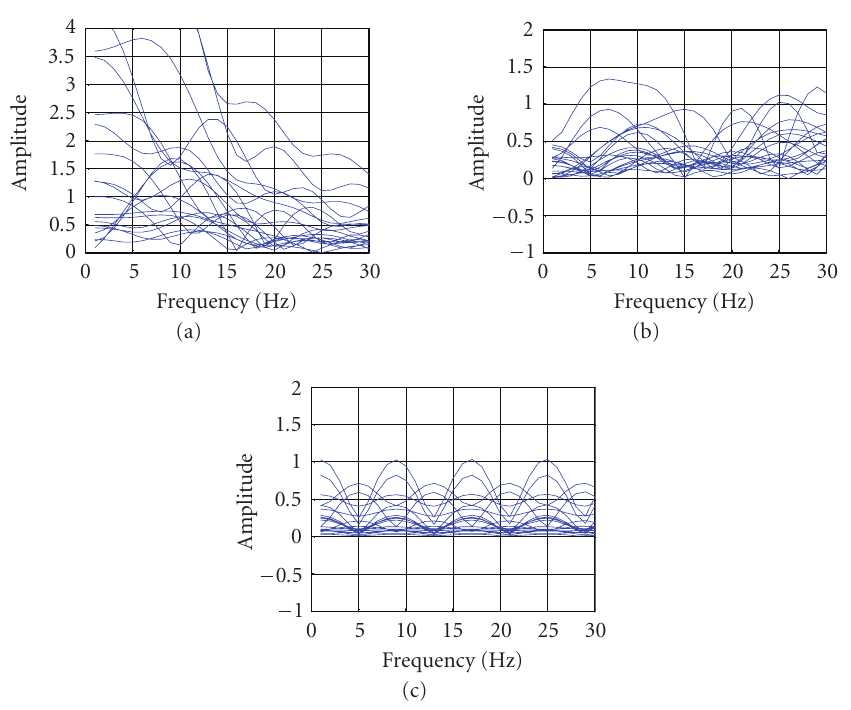
Figure 5.2 . (a) Spectrum of colored EEG noise, (b) the spectrum of a whitened EEG noise by AR Yule-Walker, (c) the spectrum of a whitened EEG noise by AR-FBLP.